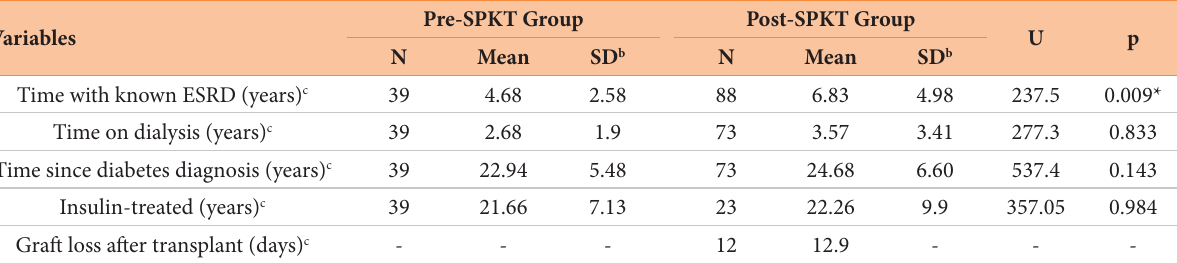
Table 2 - Description of variables related to the time factor for ESRD, diabetes, and insulin intake.